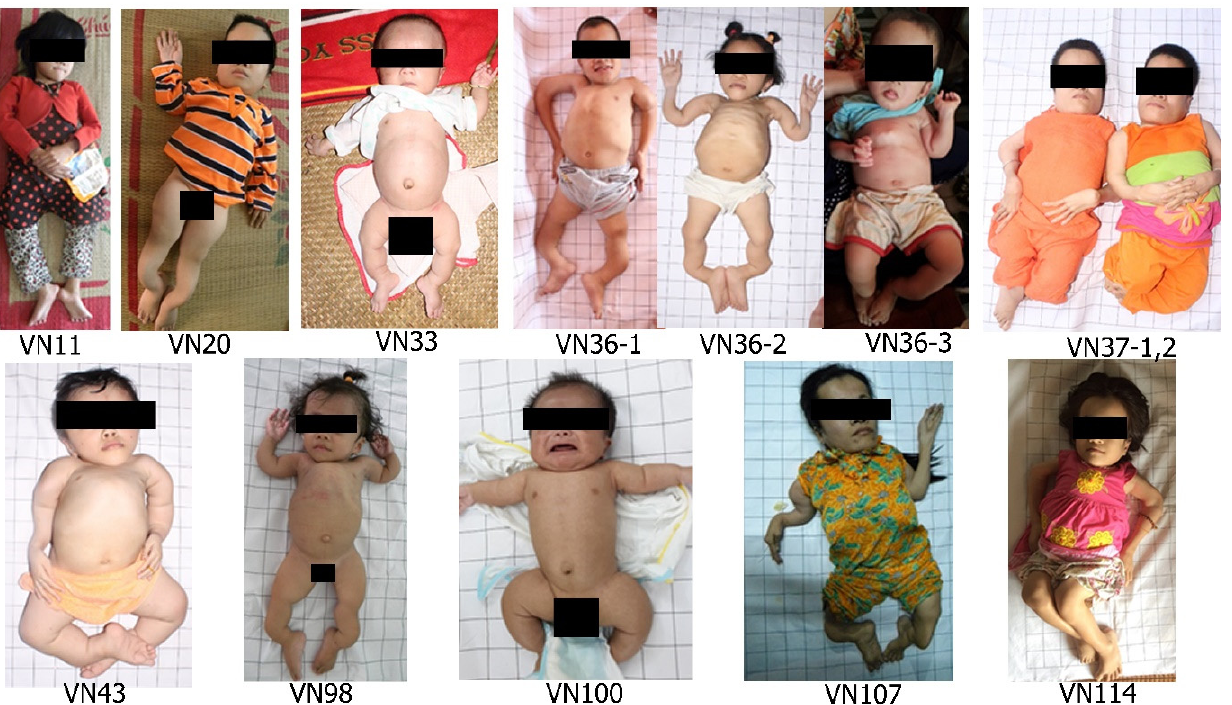
Figure 4. Patients with homozygous c.1170+5G>C P3H1 pathogenic variants. Patients share typical limb, chest, and spine deformities and disproportionally long phalanges.